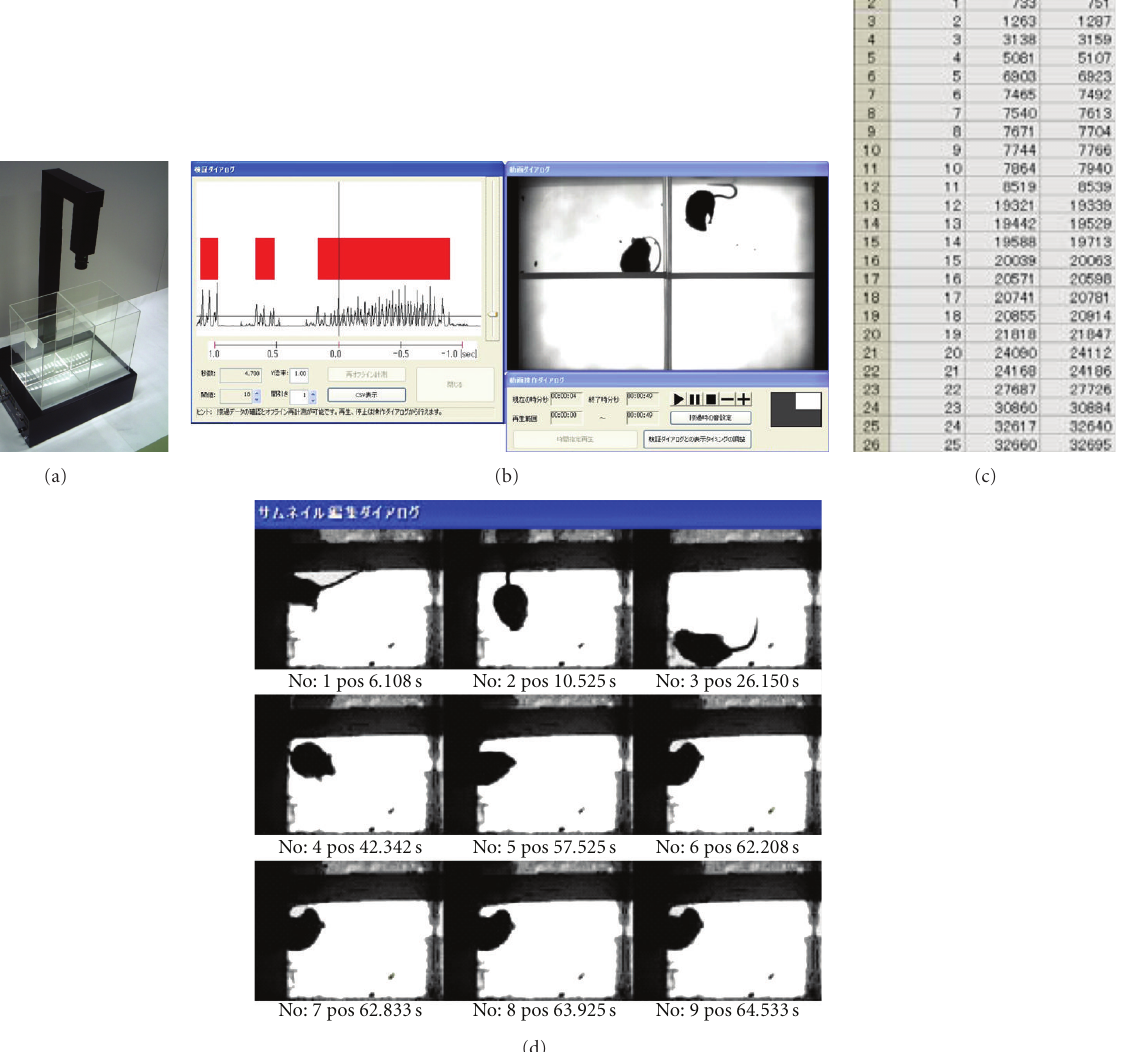
Figure 4: A novel scratch analyzing system, SCLABA-Real. (a) The high-speed camera containing image processing system and the recording platform with a built-in near-infrared light panel for real-time quantification of scratching behavior of mice. (b) Real time record and analyze window. (c) Analyzed data of scratching frequency and duration. (d) Validation window for each